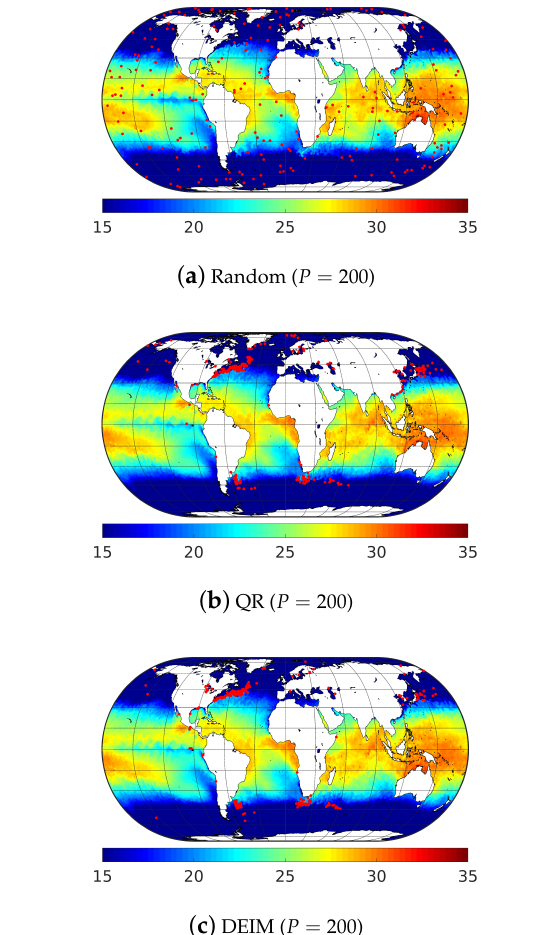
Figure 9. Illustration of the 200 most relevant sensor locations (red dots) generated using: ( a ) random; ( b ) QR-pivot; and ( c ) DEIM methods for the sea surface temperature (in ◦ C)